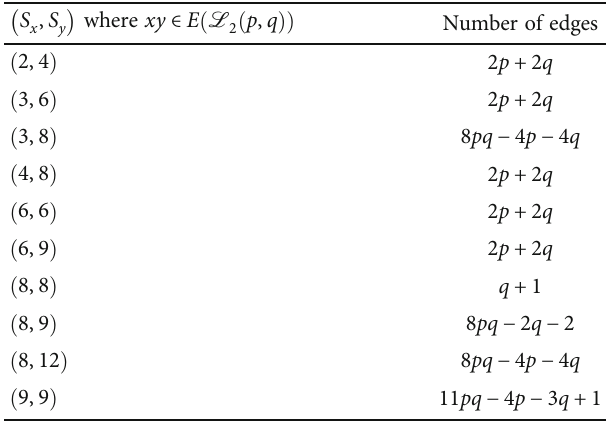
Table 4: The edge partition of L of